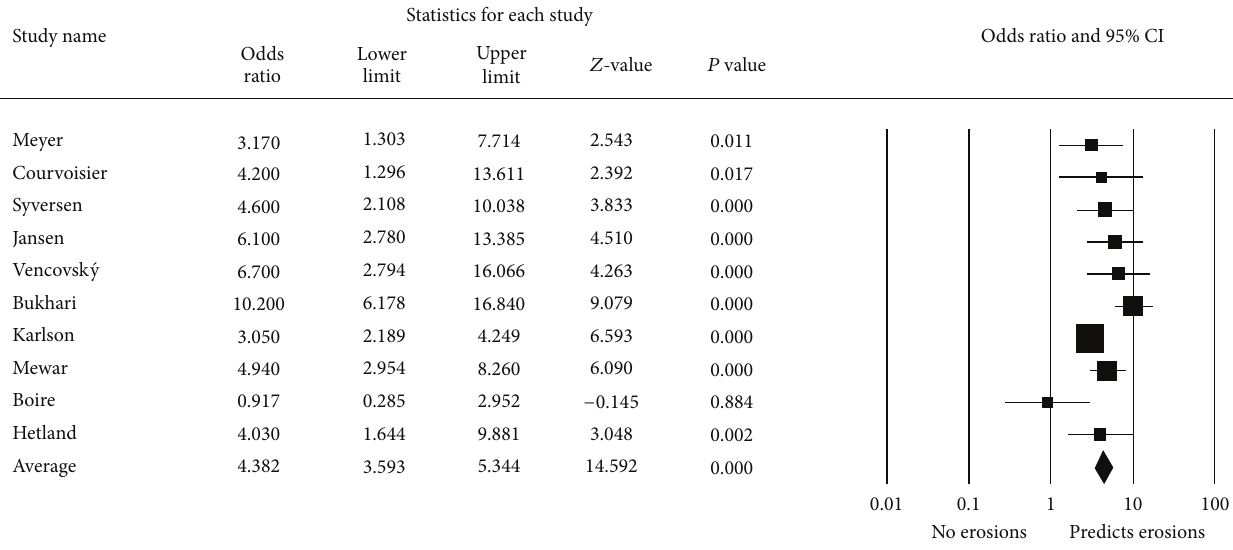
Figure 2: Meta-analysis of ACPA as predictors of erosions in rheumatoid